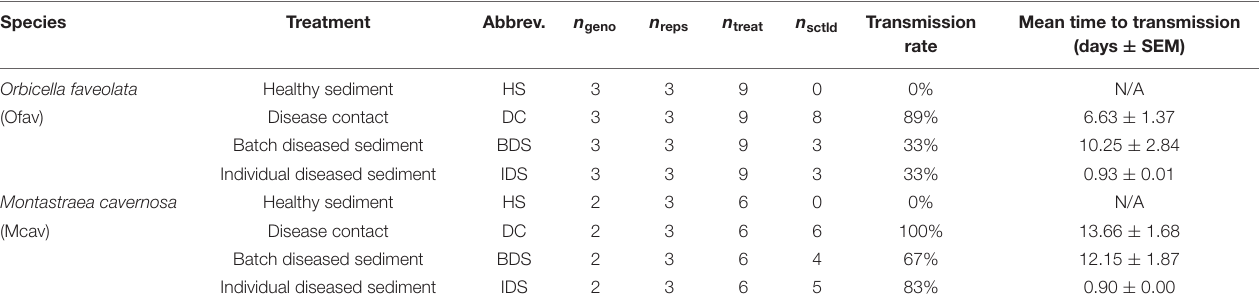
TABLE 1 | Sample sizes of Orbicella faveolata and Montastraea cavernosa fragments used for the four experimental treatments, with corresponding transmission rates and the mean time to infection by disease treatment. Species Treatment Abbrev. n geno n